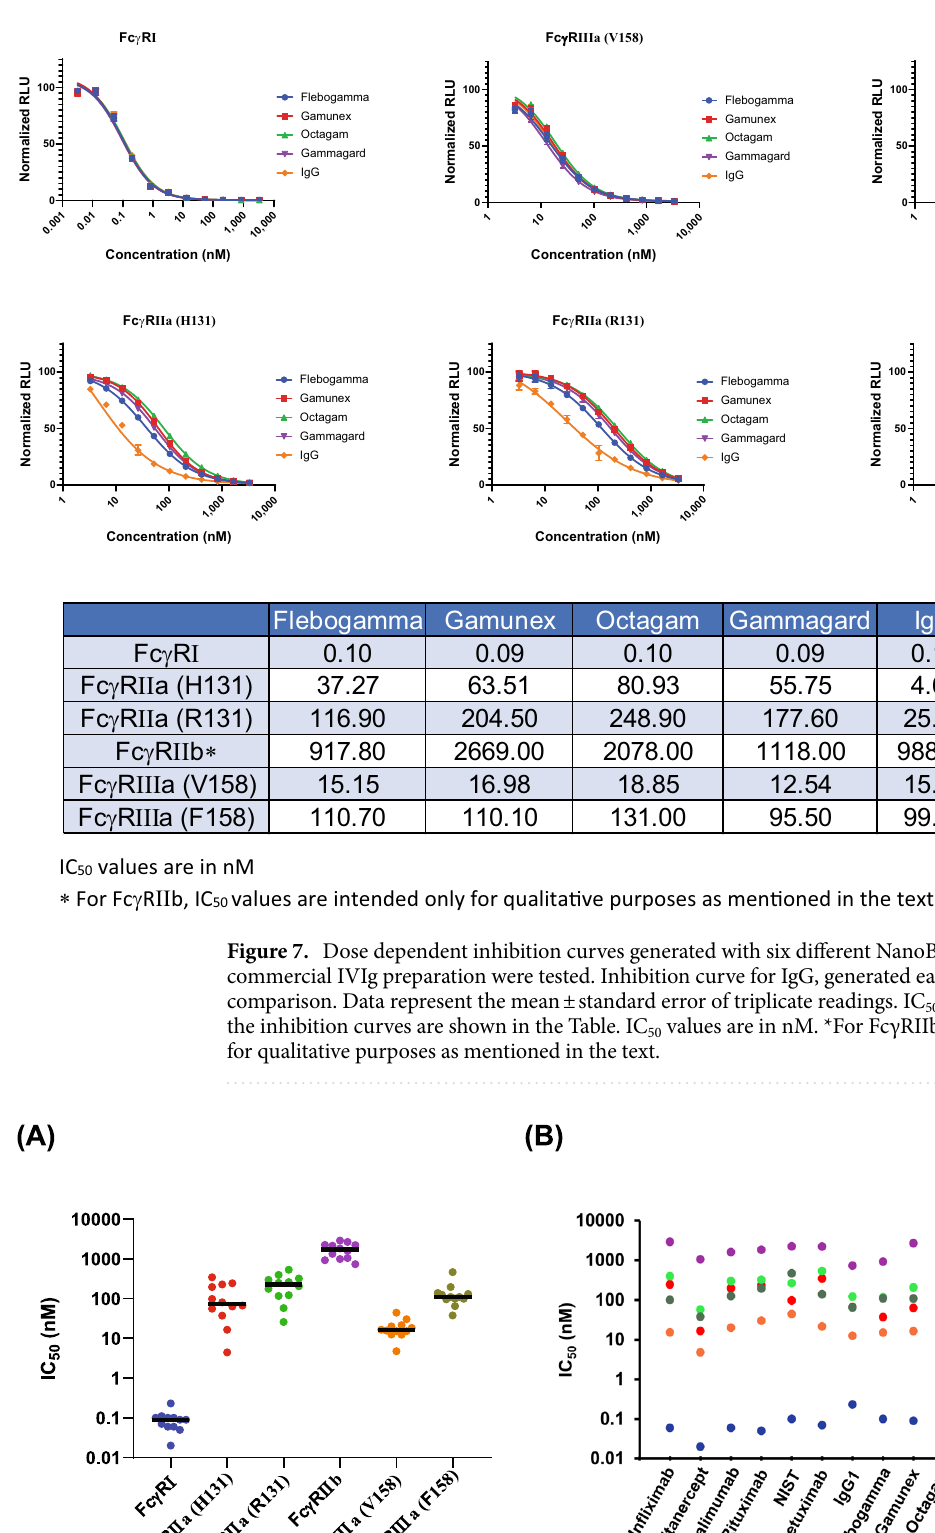
Figure 8. Scatter plot of the IC 50 values of seven IgG1 antibodies and five different polyclonal IgG plotted two different ways. Lines are the median values. These plots demonstrate the potential advantage of matrix-screening method as a visual aide during large antibody discovery